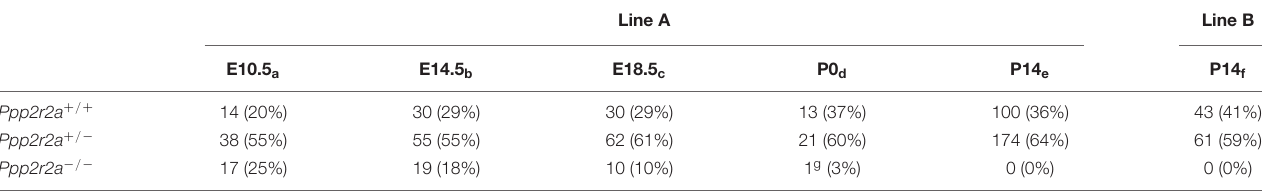
TABLE 1 | Number of mice per genotype at various embryonic and post-natal